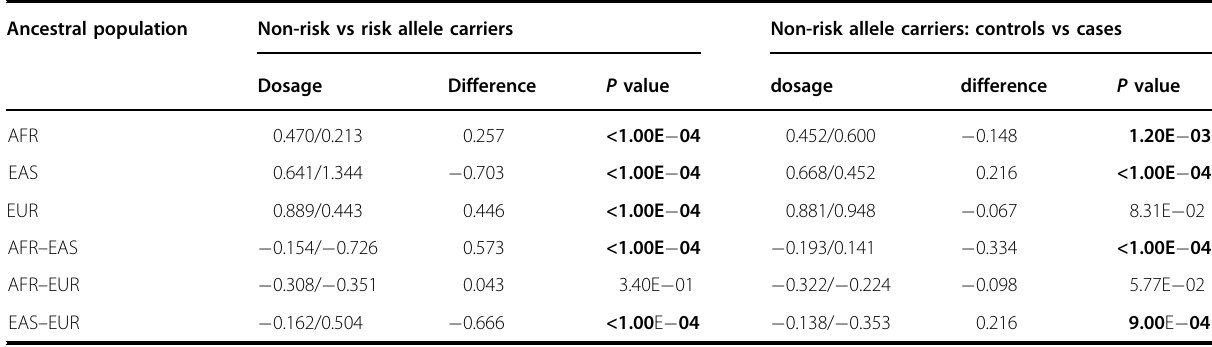
Table 1 Local ancestry estimates in individuals of European ancestry for ancestral populations AFR, EAS and EUR. Ancestral